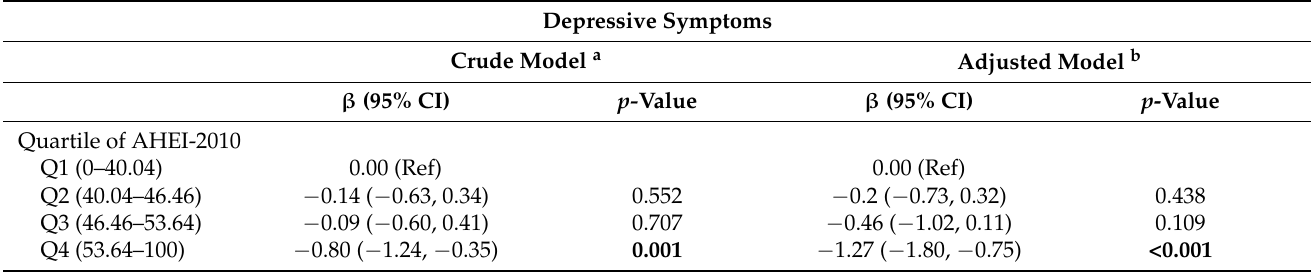
Table 3. β ( p ) of the depressive symptoms according to the quartile of